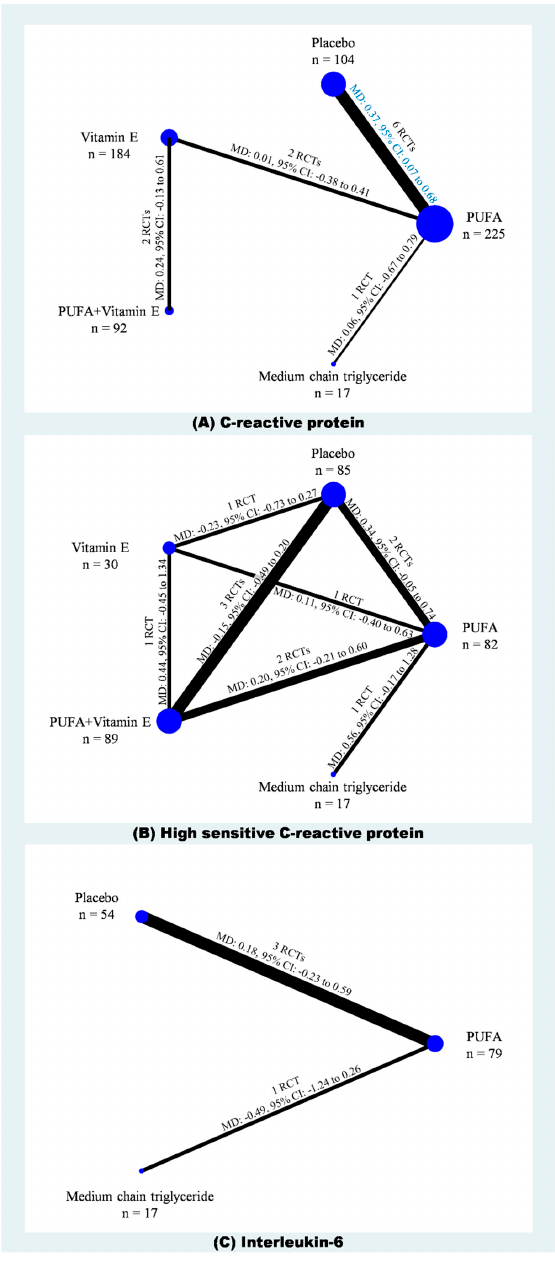
Figure 2. Network plots of ( A ) CRP, ( B ) high sensitivity CRP, and ( C ) IL-6.